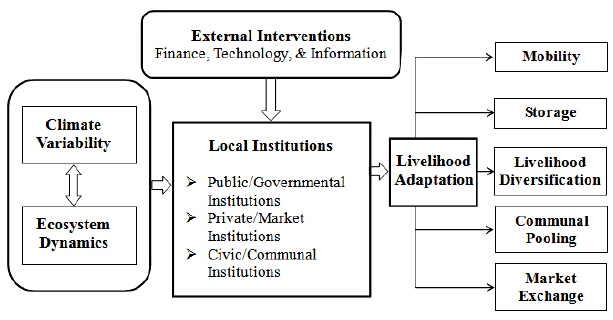
Fig. 1 . The adaptation, institutions, and livelihoods (AIL) framework for analyzing climate adaptation of herder communities on the Tibetan Plateau. The framework was modified from Agrawal and Perrin